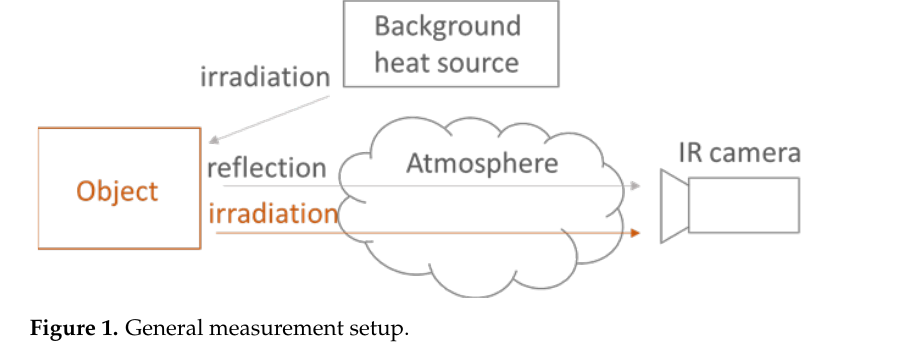
Figure 1. General measurement setup.